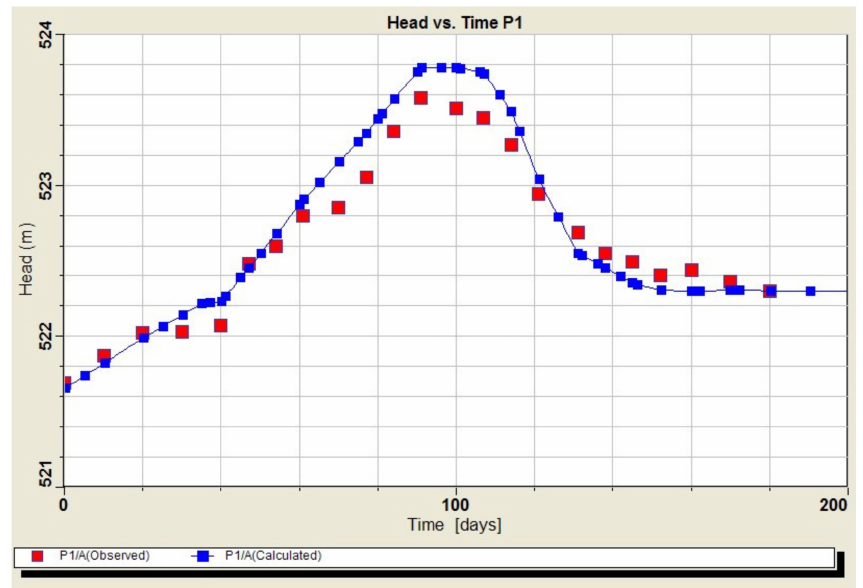
Figure 7. Model calibration vs. observed groundwater head fluctuations in the P1 observation piezometer, April 2017 to November